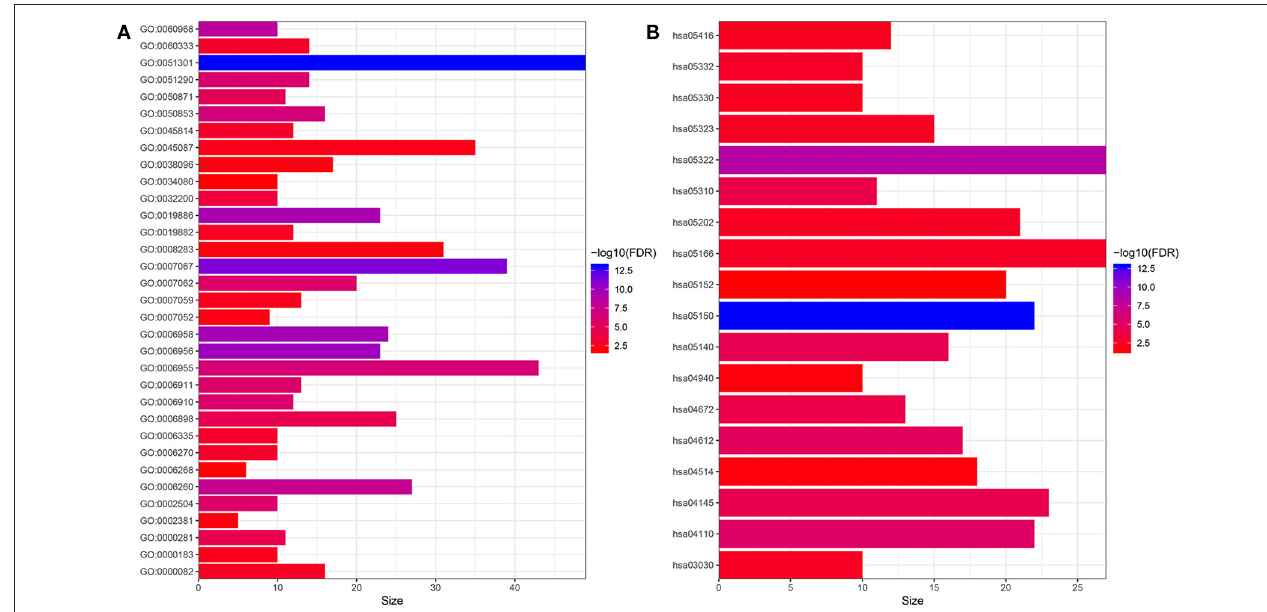
FIGURE 1 | Functional enrichment analysis of hub genes. (A) GO enrichment analysis. (B) KEGG enrichment analysis. GO:0051301 ∼ cell division, GO:0007067 ∼ mitotic nuclear division, GO:0006956 ∼ complement activation, GO:0006958 ∼ complement activation, classical pathway, GO:0019886 ∼